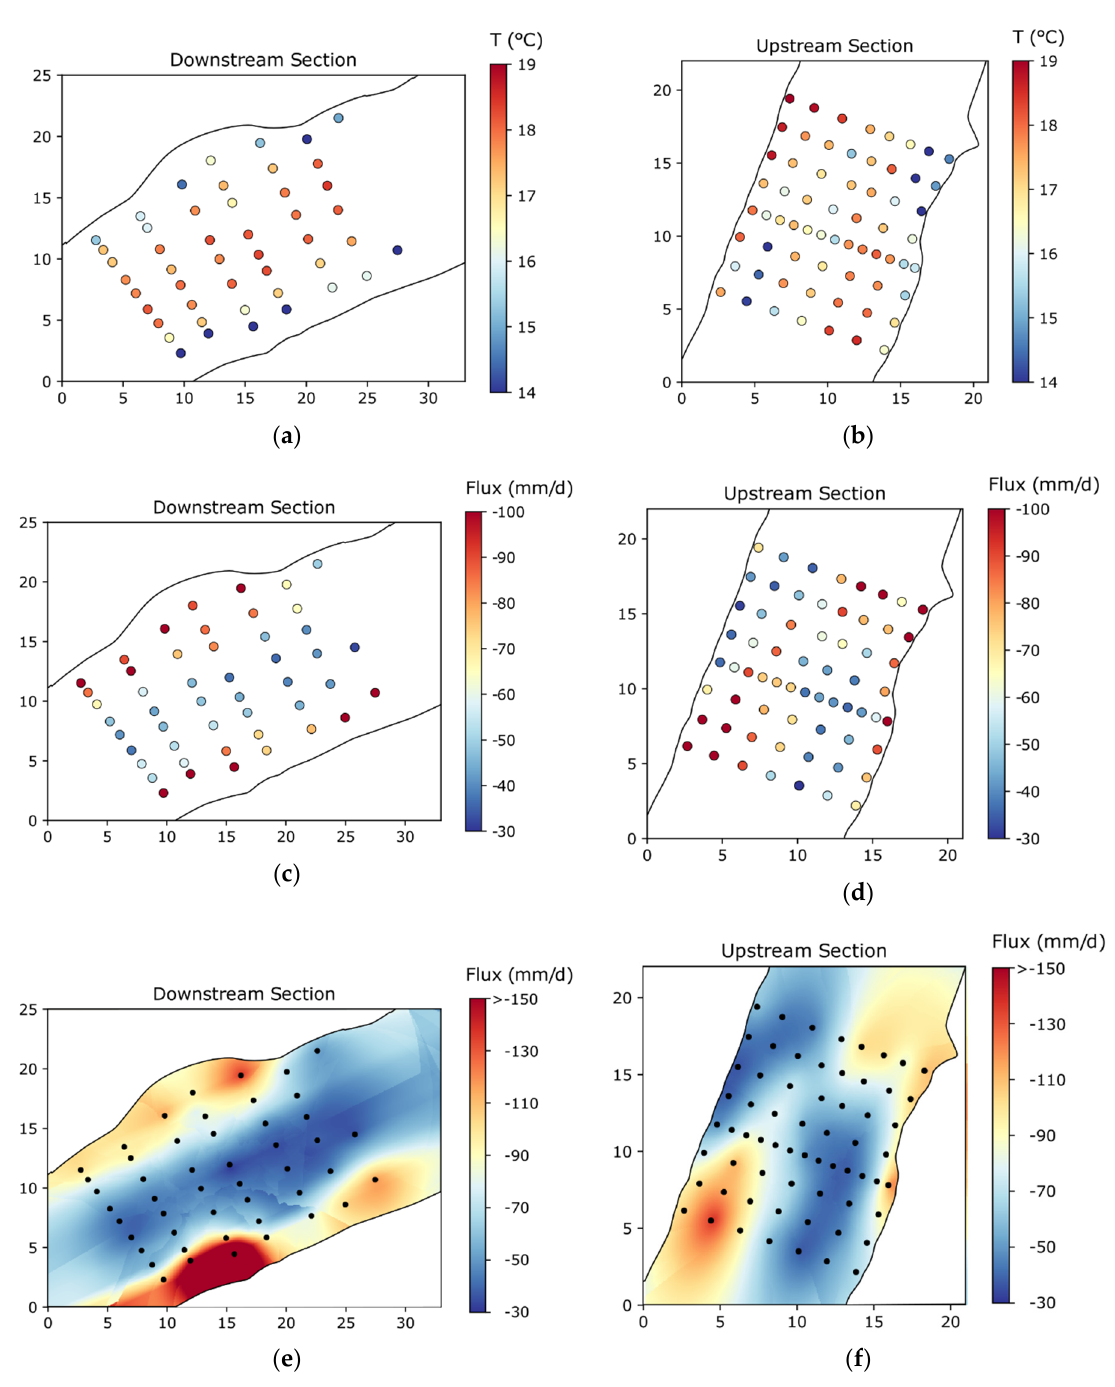
Figure 4. Spatial distribution of temperature at the river–riverbed interface (depth of 0.1 m in the riverbed) for ( a ) the downstream and ( b ) the upstream section; exchange flux estimates for ( c ) the downstream and ( d ) the upstream section; interpolated exchange flux estimates for ( e ) the downstream and ( f ) the upstream section. Black dots indicate measurement locations of the vertical temperature profiles.